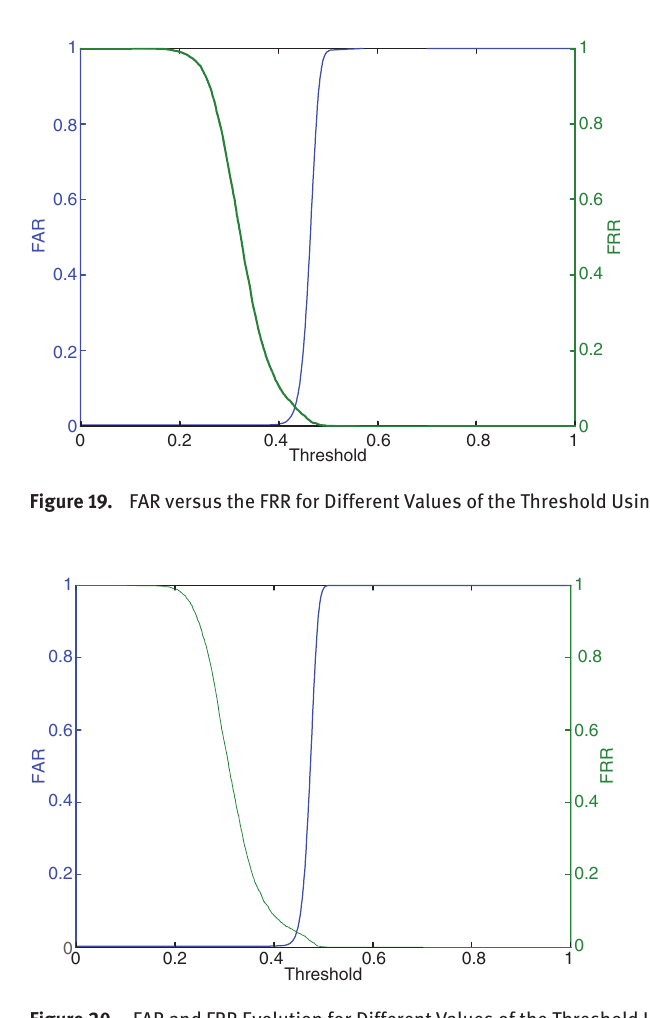
Figure 20. FAR and FRR Evolution for Different Values of the Threshold Using Modified HD.